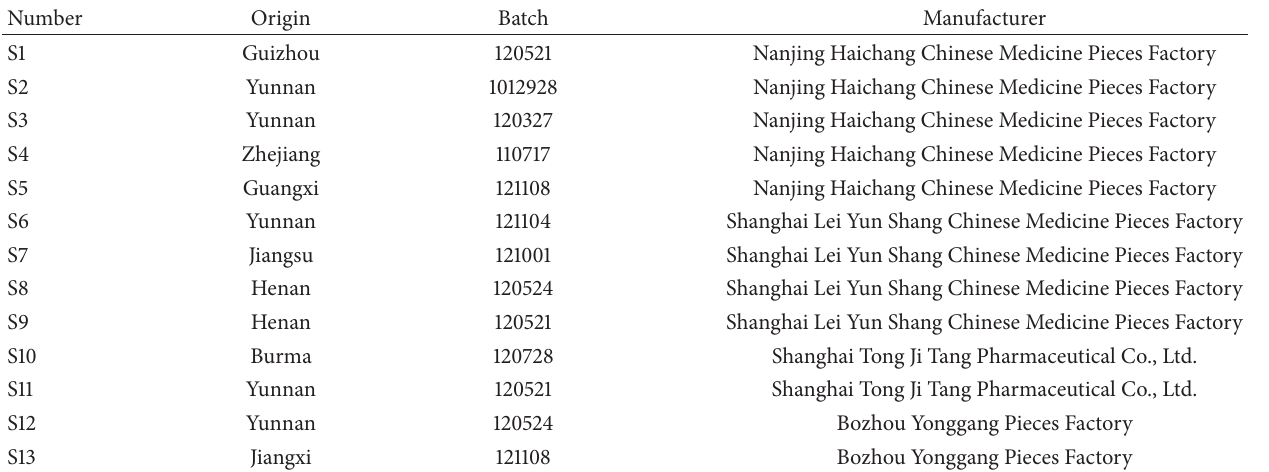
Table 1: The information of the crude pieces of P. corylifolia